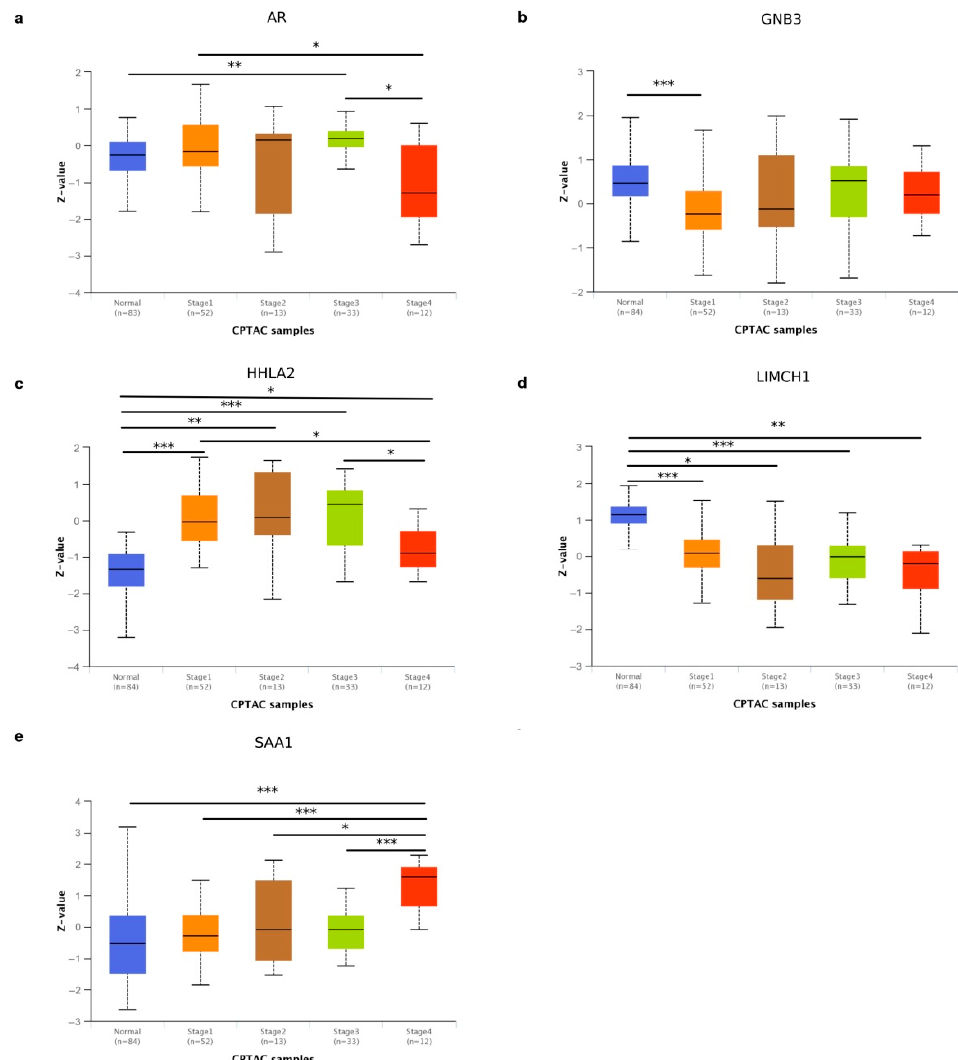
Figure A8. Forest plot for Cox proportional hazards model displaying the significative genes (AL353637.1, DPP6, FOXJ1, HHLA2, and SAA1). The statistical significance between comparisons is given by * p -value < 0.05, ** p -value < 0.01, and *** p -value < 0.001.